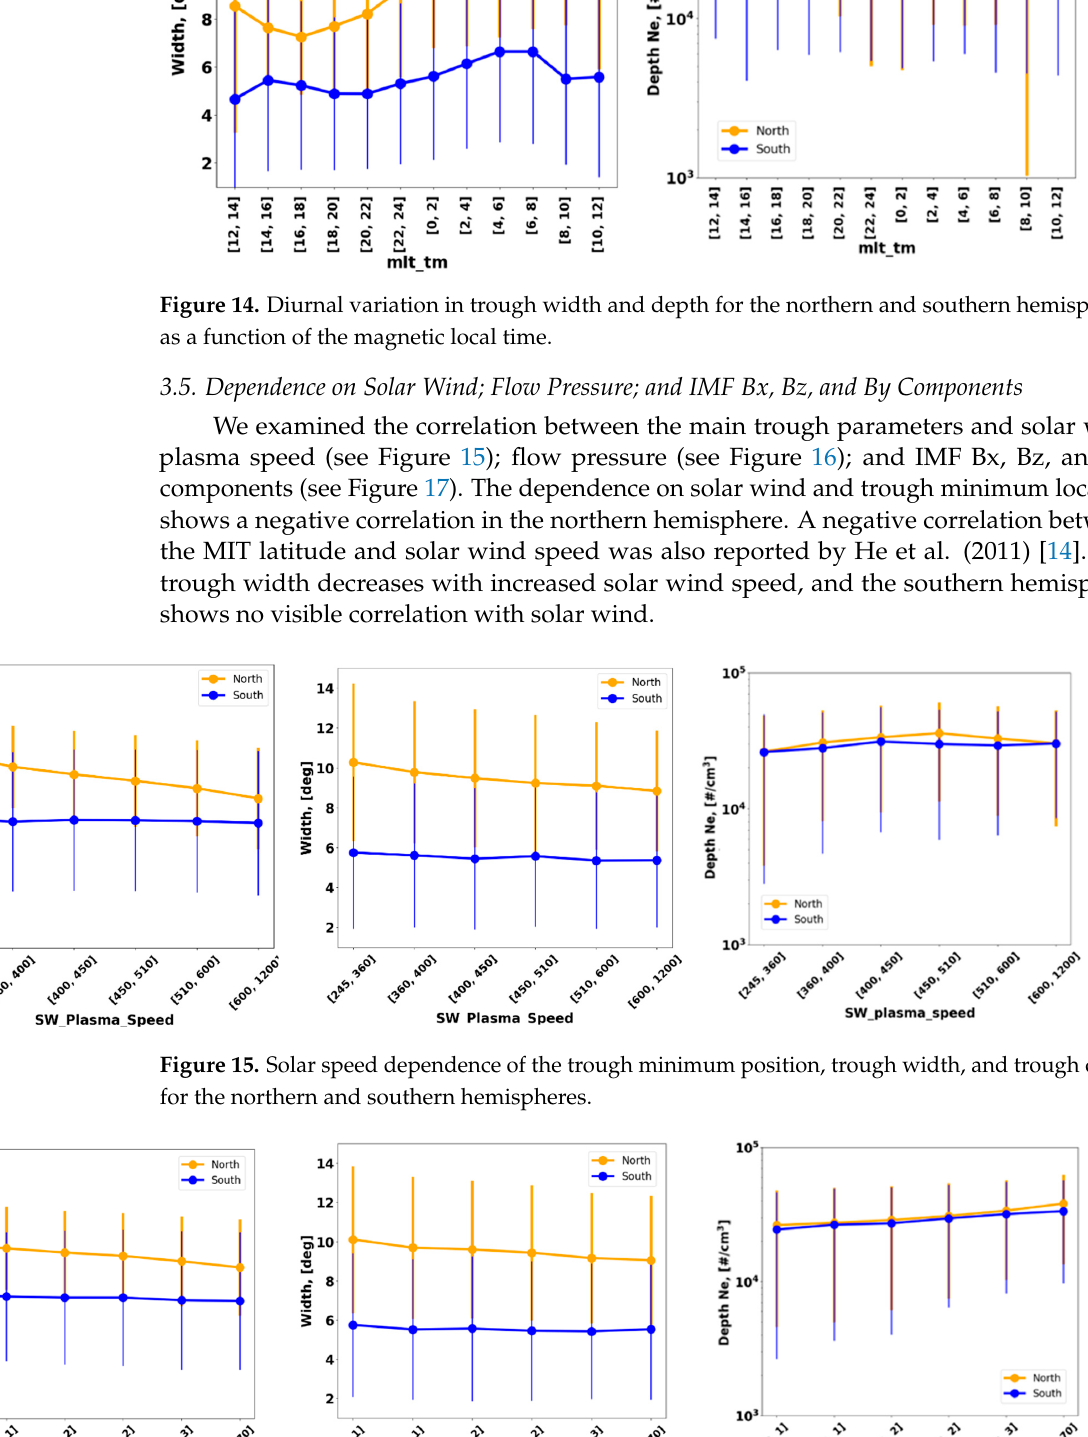
Figure 17. Bx (blue), By (orange), and Bz (green) component dependence of the trough minimum position, trough width, and trough depth for the northern and southern hemispheres. 3.6. Dependence on the SYM-H Index The SYM-H index is similar to the Dst-index but has a different time resolution and method to determine the base value. The temporal resolution of the SYM-H index is 1 min. Wanliss et al. [28] found that the SYM-H index is accurate and should be used as a